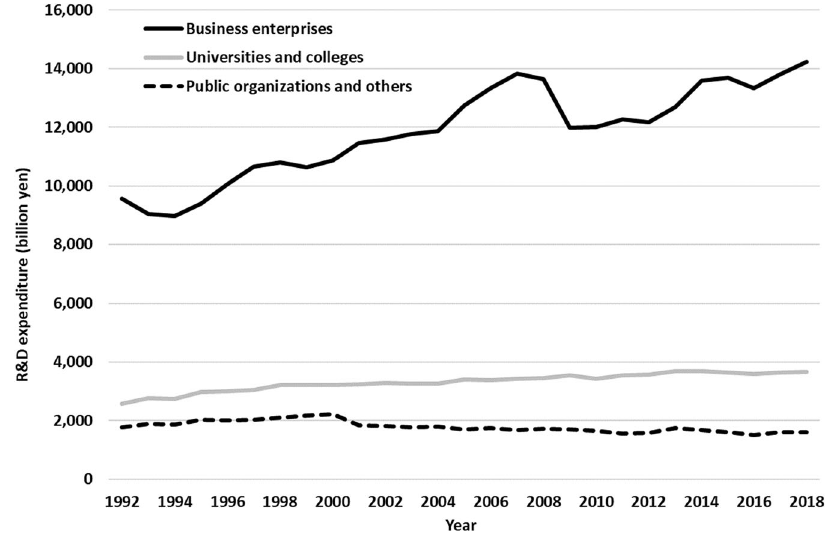
Fig. 1 Trends in R&D expenditure by sector. R&D expenditure is a nominal value. Source: NISTEP